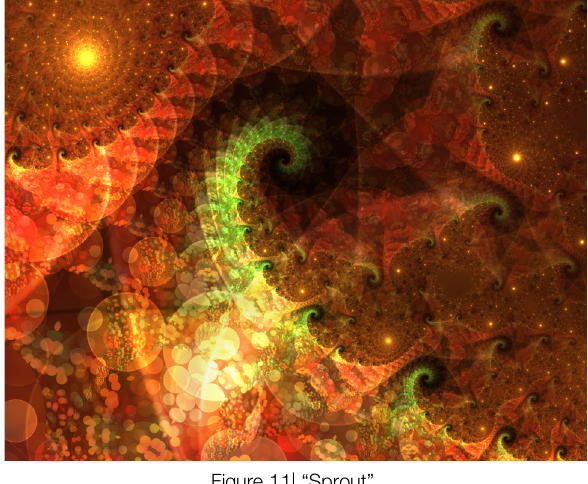
Figure 11| “Sprout”.